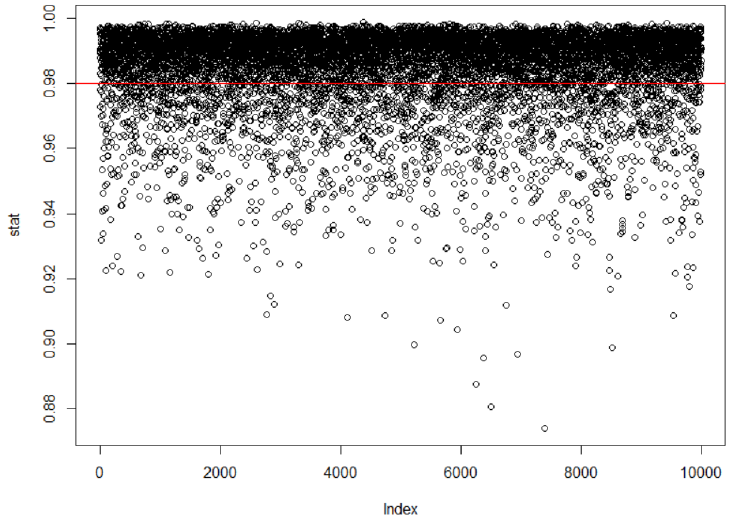
Figure 10. The values of the statistic W i evaluated according to Equation (7).